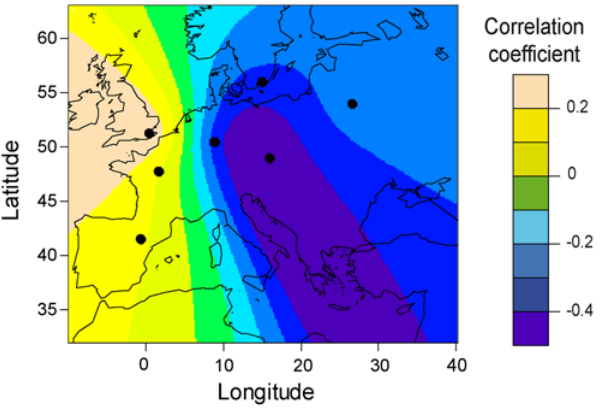
Figure 2. Diversity regressed on geographic distance. Correla- tion ( R ) map for the linear regression of expected heterozygosity on great circle distance. We used 300 6 180 points on a two-dimensional lattice covering Europe, and we computed distances from each lattice point considered as a potential source. The dots represent the centers of the 7 population samples used in the regression analysis.